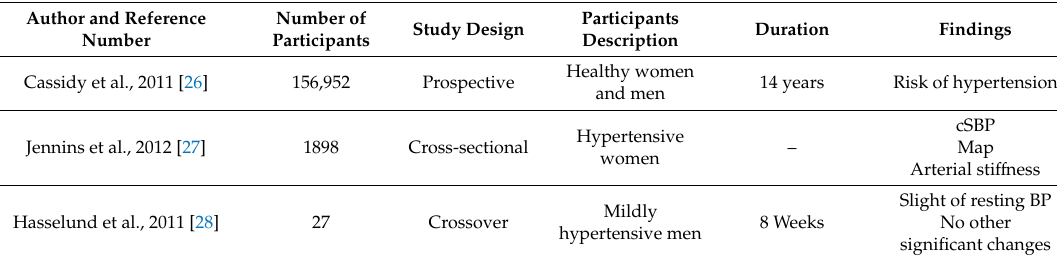
Table 1. Comparison of